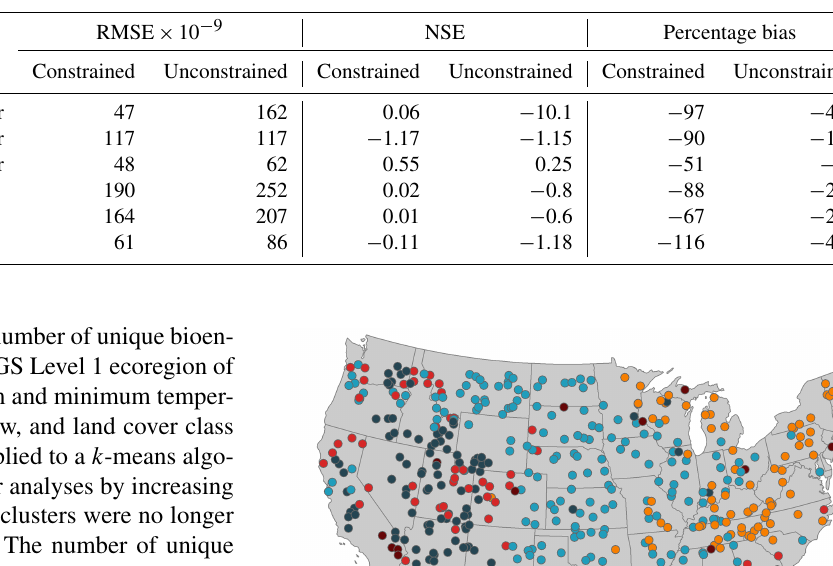
Table 1. NSE, RMSE, and percentage bias (estimated as sum ( sim − obs ) and coniferous plant functional types across all sites.